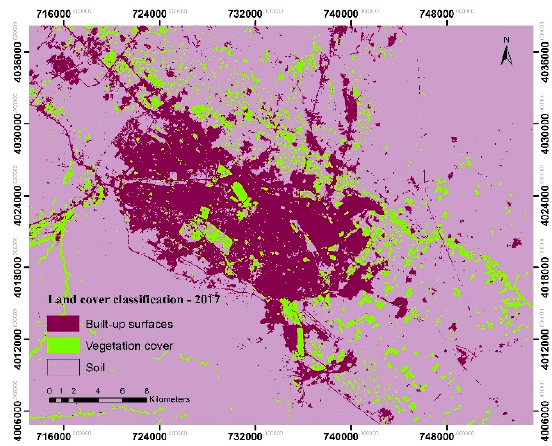
Figure 2. Land cover classification, 1988, 2001 and 2017.